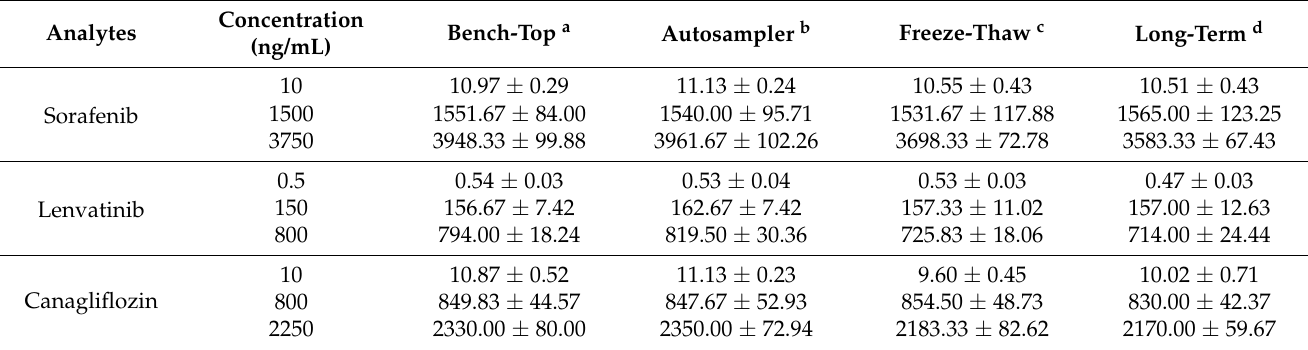
Table 3. Stability of sorafenib, lenvatinib, and canagliflozin in rat plasma under various storage conditions (n =